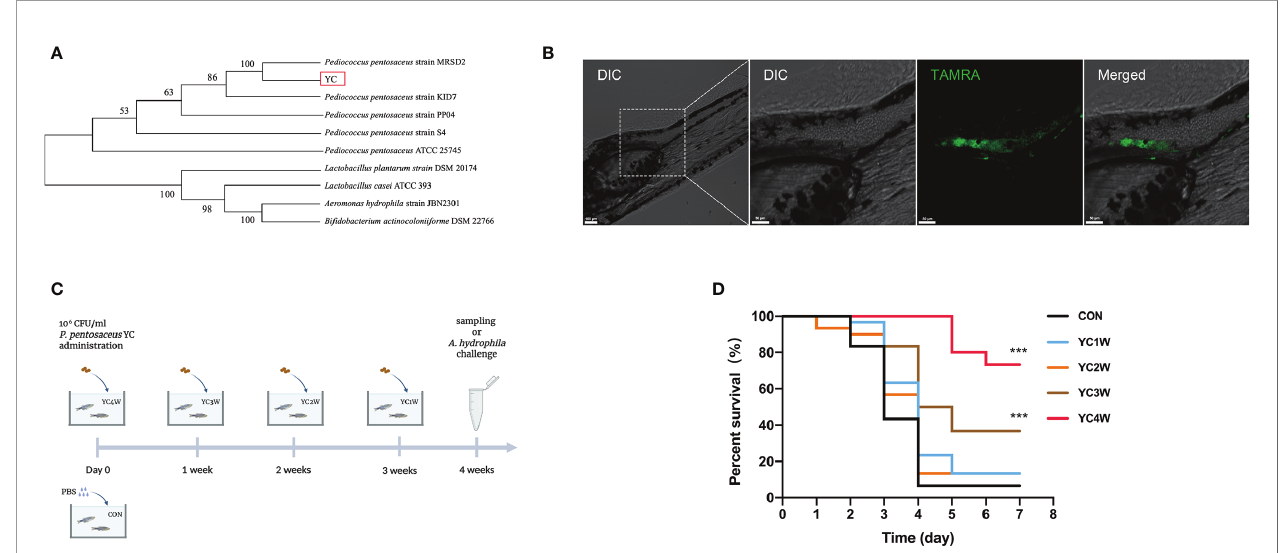
FIGURE 1 | Administration of the isolated bacteria YC and its protective effect on the resistance against A. hydrophila of zebra fi sh. (A) Phylogenetic tree of the isolated bacteria bacterium. Distance was calculated by using 16S rRNA gene based on the neighbor-joining criterion and the bootstrap con fi dence values were 100 replicates. (B) Confocal fl uorescence imaging of zebra fi sh larvae (4 dpf) immersed in water containing 10 6 CFU/ml P. pentosaceus YC (pre-treated with 300 µM TAMRA) for 24 h. (C) Experimental design for accessing the protective effect of P. pentosaceus YC administration. YC was administrated into water at a concentration of 10 6 CFU/ml for 1 week (YC1W), 2 weeks (YC2W), 3 weeks (YC3W), and 4 weeks (YC4W). PBS treatment as control group (CON). YC or PBS were provided every 24 h for different durations. (D) Survival curve of zebra fi sh from different groups following 10 8 CFU/ml A. hydrophila challenge. Each curve represents the sum of three independent tanks. *** p < 0.001 by Mantel – Cox